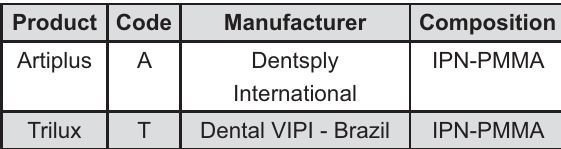
Figure 1- Denture tooth acrylic resins used in this study